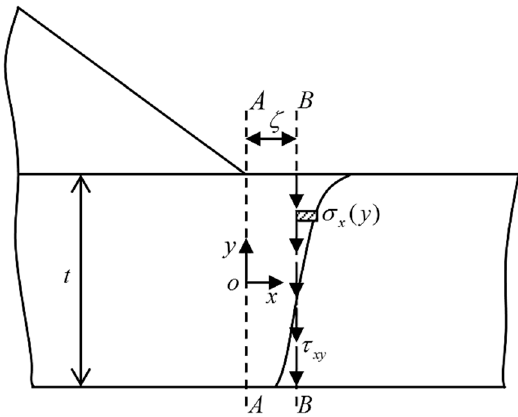
Figure 2. Through-thickness stress distributions in section B-B.